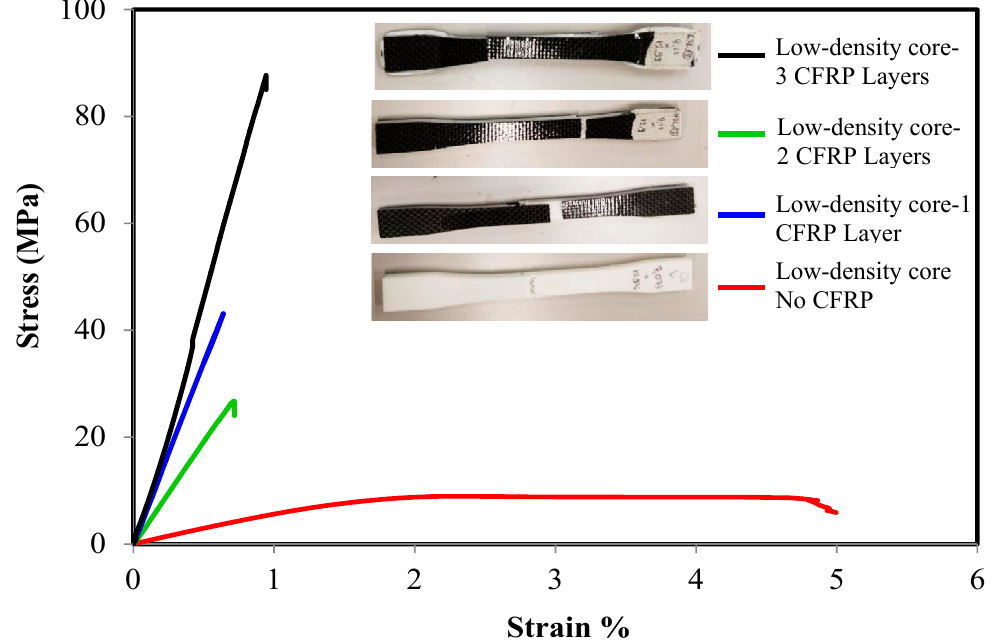
Figure 4. Typical tensile stress-strain response of low-density core CFRP/ABS/CFRP composite samples.